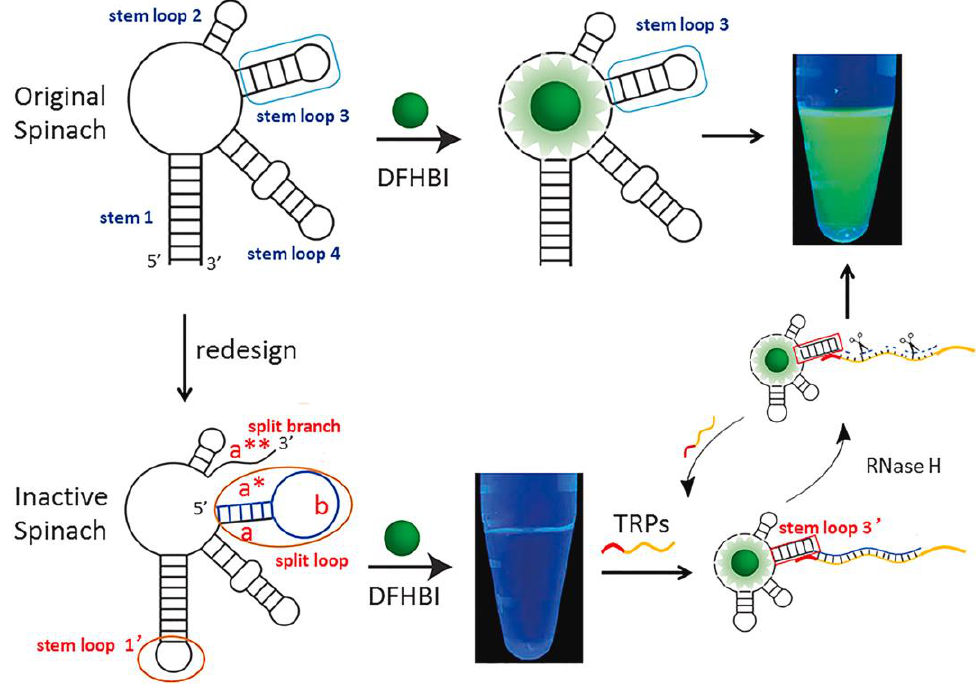
Figure 5. Principle of the telomerase reaction product-initiated Spinach reconstruction. Reprinted with permission from [45] Copyright (2022) Elsevier.